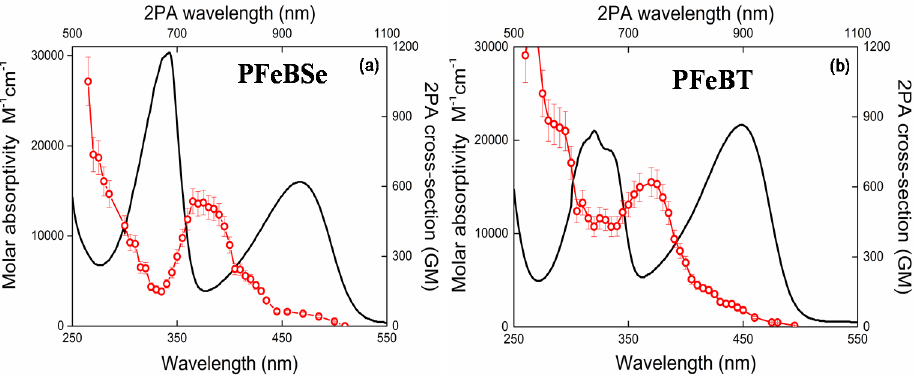
Figure 2. 1PA (solid lines, bottom x -axis and left y -axis) and 2PA (circles, top x -axis and right y -axis) spectra for ( a ) PFeBSe and ( b ) PFeBT polymers respectively.